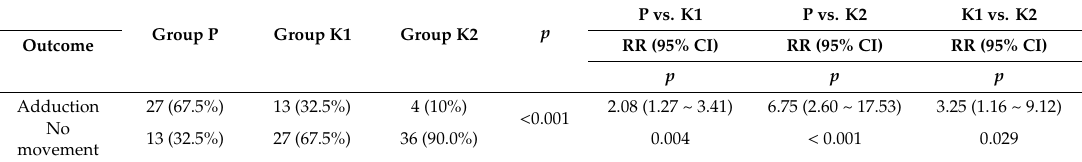
Table 2. Incidence of adduction motion as primary outcome.